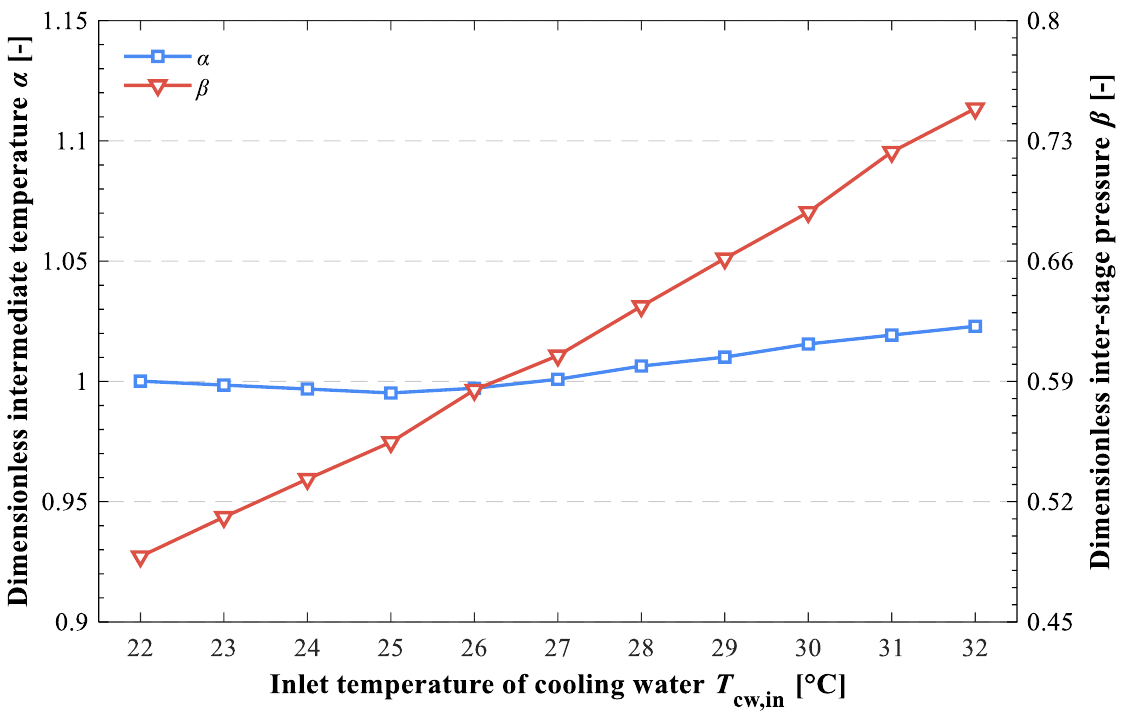
Figure 14. Effect of inlet temperature of cooling water on dimensionless optimum intermediate temperature and inter-stage pressure.